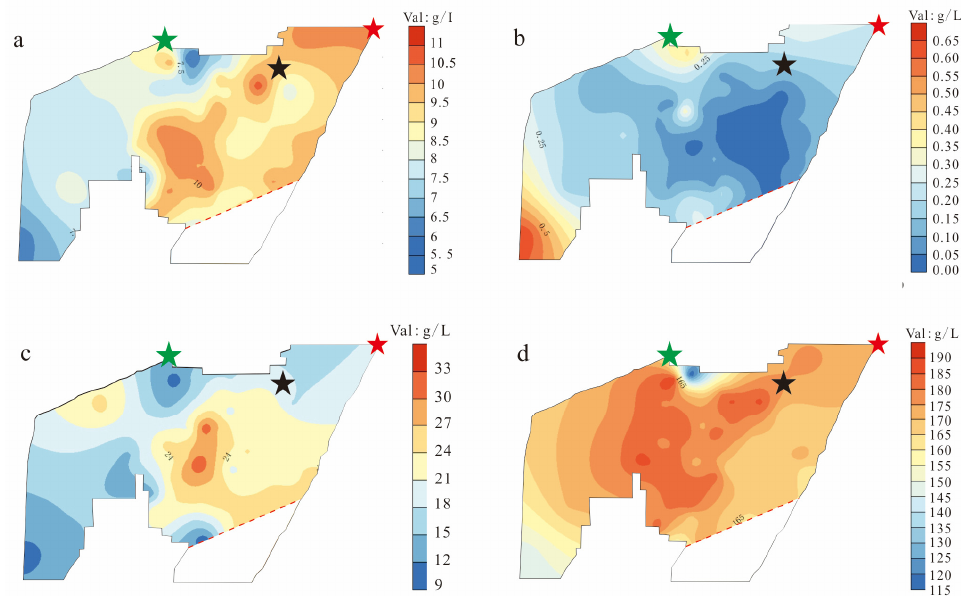
Figure 6. Distribution of K + , Ca 2+ , Mg 2+ , and Cl − in Lop Nor mining areas; ( a ) shows the distribution of K + , ( b ) shows the distribution of Ca 2+ , ( c ) shows the distribution of Mg 2+ , and ( d ) shows the distribution of Cl − in the Lop Nor Playa. The coordinates of ★ are 90°53′05″ E, 41°06′03″ N, the coordinates of ★ are 91°15′05″ E, 41°03′36″ N, the coordinates of ★ are 91°37′04″ E, 41°10′03″ N [66] (Testing results of water samples are shown in Appendix A below).